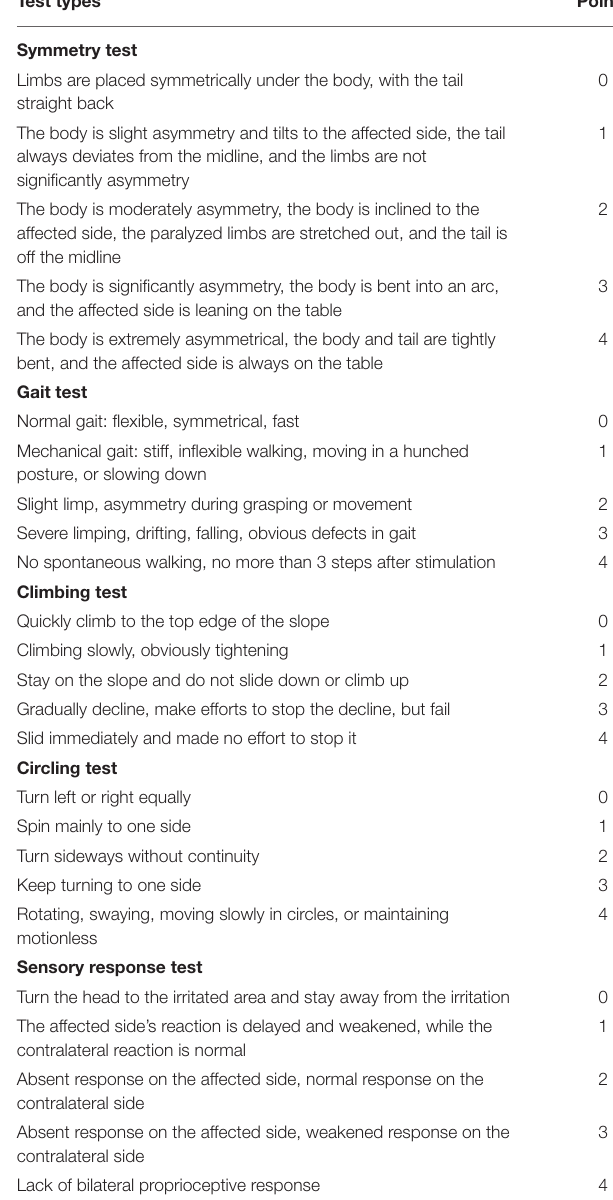
TABLE 2 | The scoring scheme of the general deficits in fur, ears, eyes, body position, spontaneous activity, and epilepsy. Test types